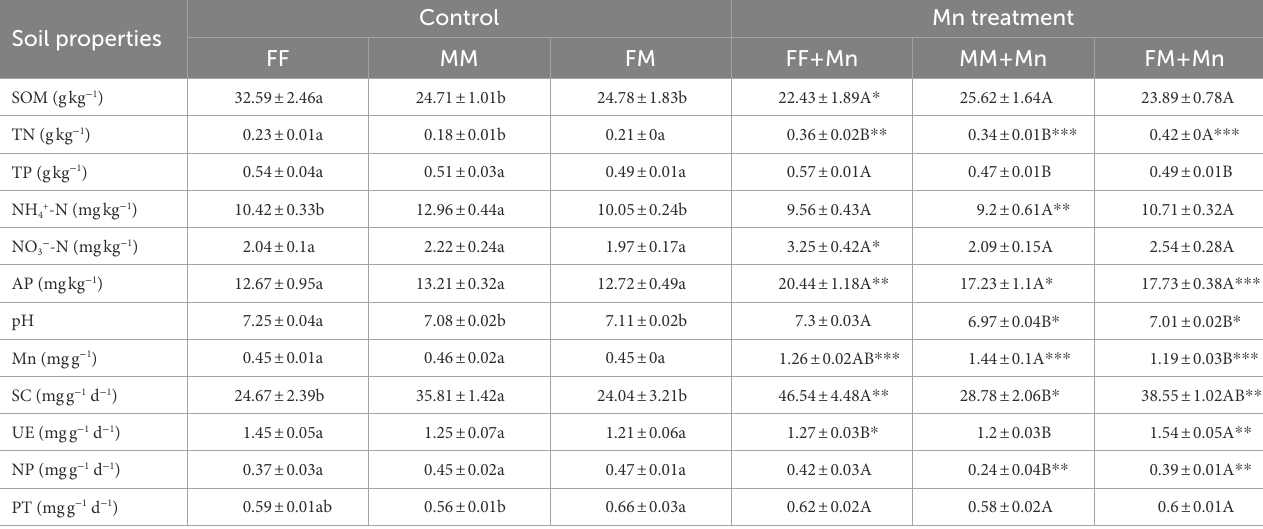
TABLE 1 Soil physical and chemical properties and enzyme activities under different competition and Mn treatments.